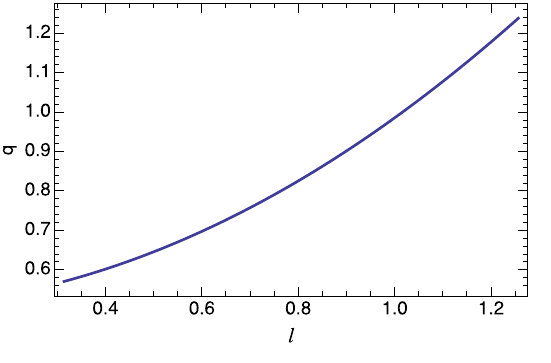
FIG. 6. Plot of q versus l for r ¼ 0 . 2 .